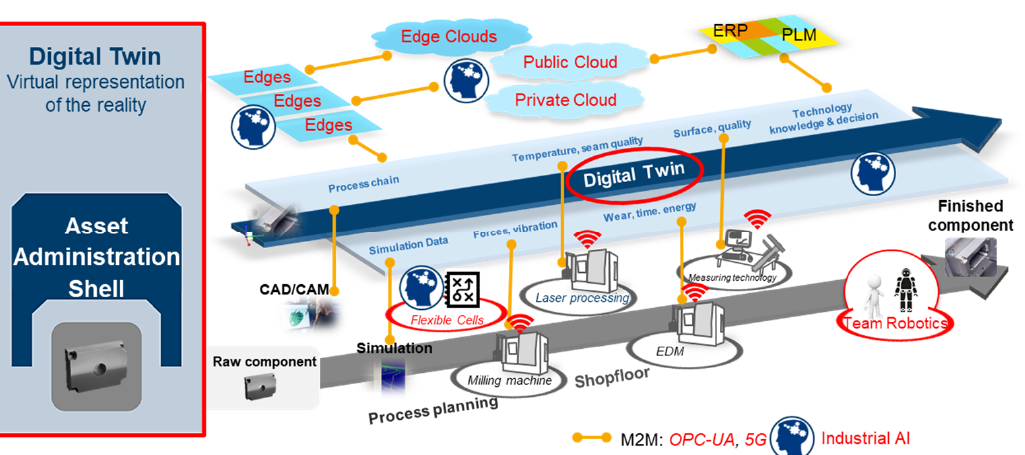
Figure 2. Megatrends for the next level of Industrie 4.0 (own illustration).